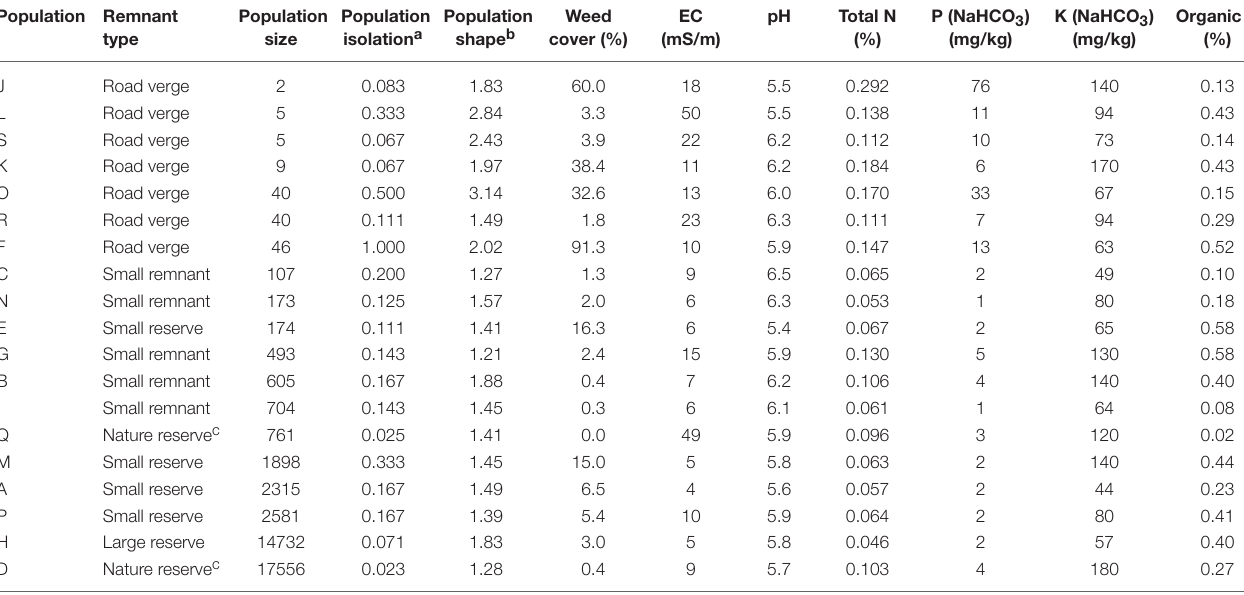
TABLE 1 | Physical characteristics of 19 Eucalyptus wandoo populations sampled for this study. Population Remnant Population type